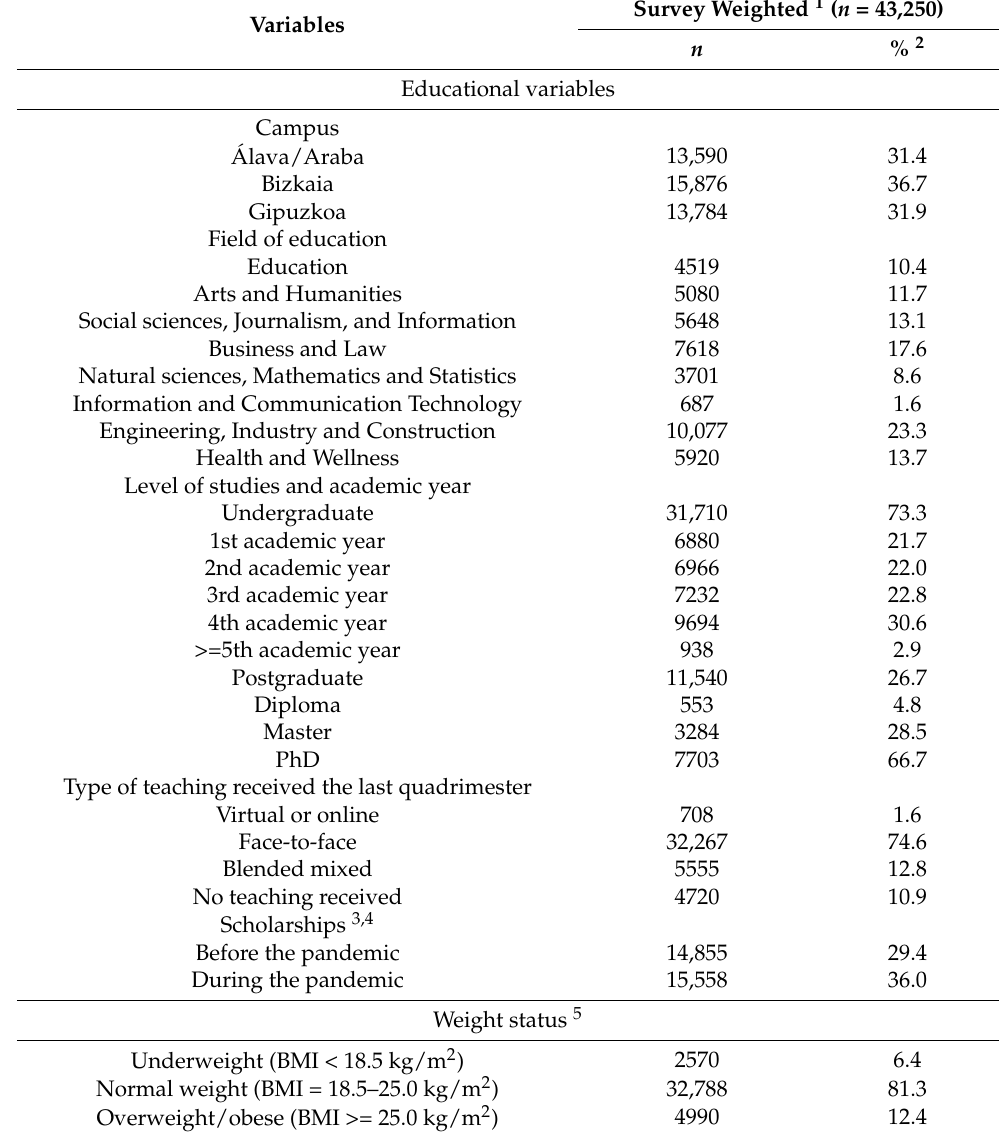
Table 2. Educational characteristics and weight status of the sample: students of the University of the Basque Country